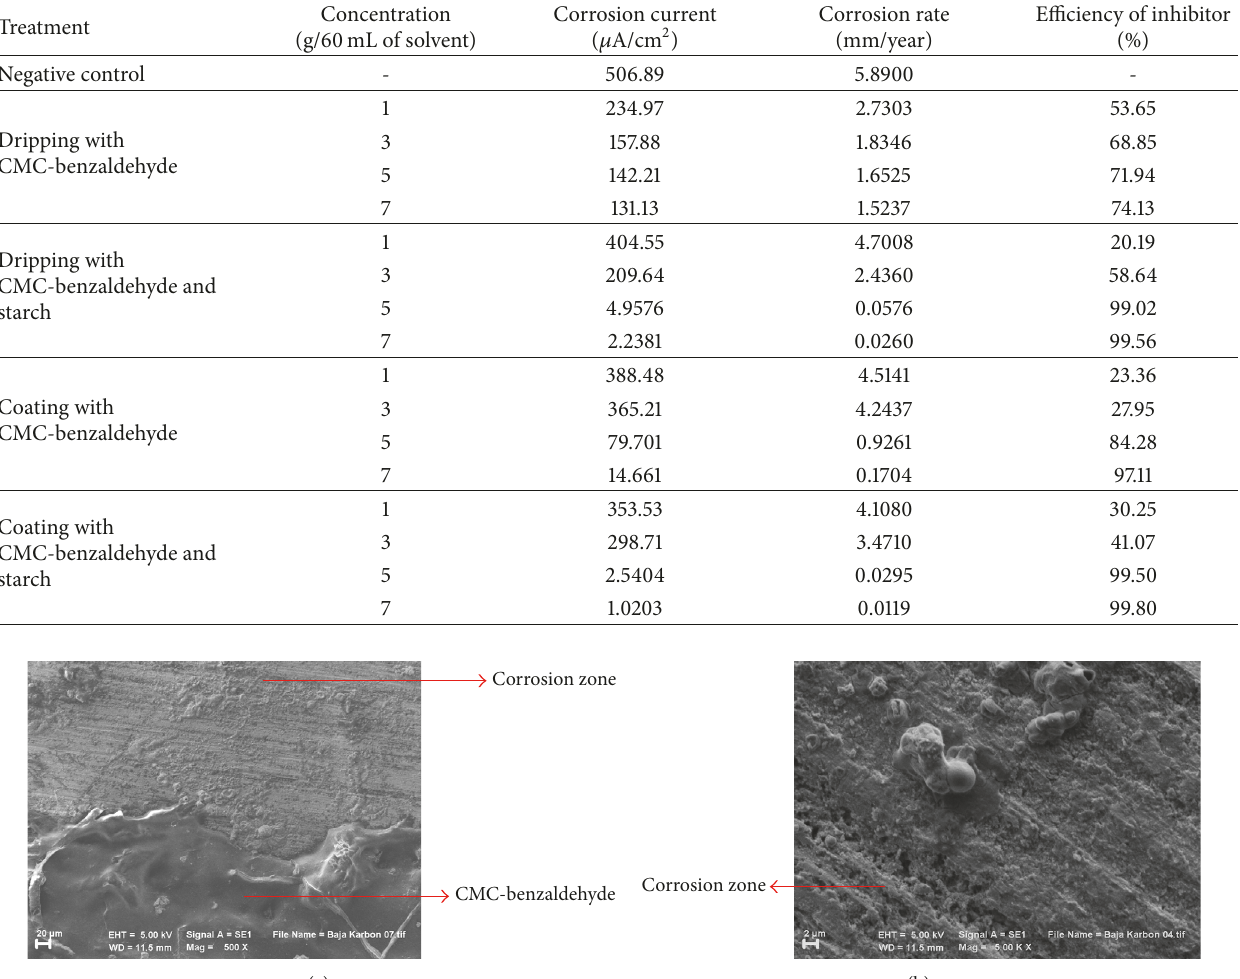
Table 3: The effect of concentration of CMC-benzaldehyde with and without the addition of starch on the dripping and coating methods to the corrosion current, corrosion rate, and inhibition efficiency.